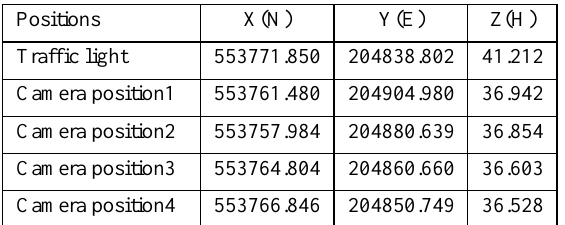
Table 1. Different 4 positions on different distance were measured away from one traffic